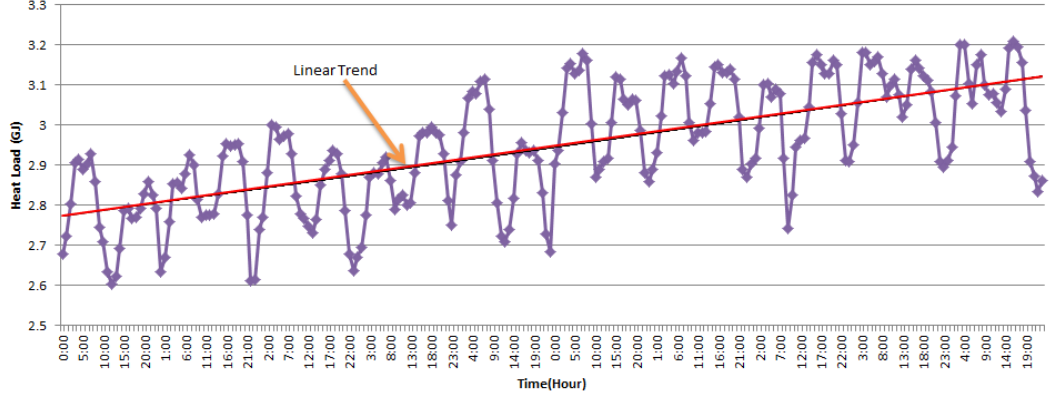
Figure 1. Time characteristics of the heat load.